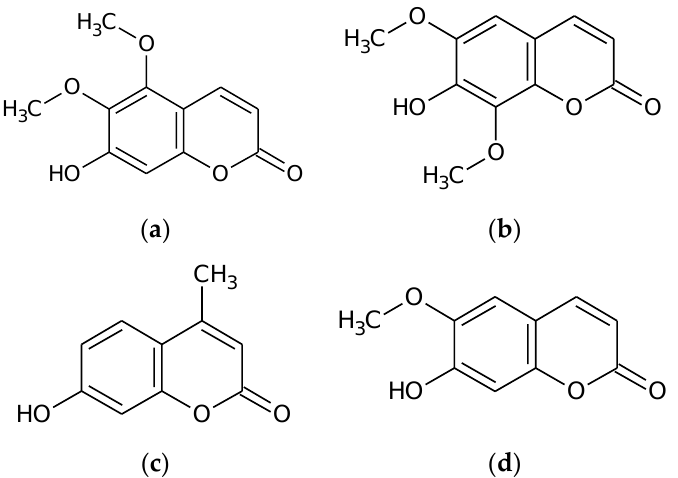
Figure 1. The structure of the 7-hydroxy coumarin derivatives: ( a ) 7-hydroxy-5,6-dimethoxycoumarin, ( b ) 7-hydroxy-6,8-dimethoxycoumarin, ( c ) 7-hydroxy-4-methlycoumarin, and ( d ) 7-hydroxy-6- methoxycoumarin.